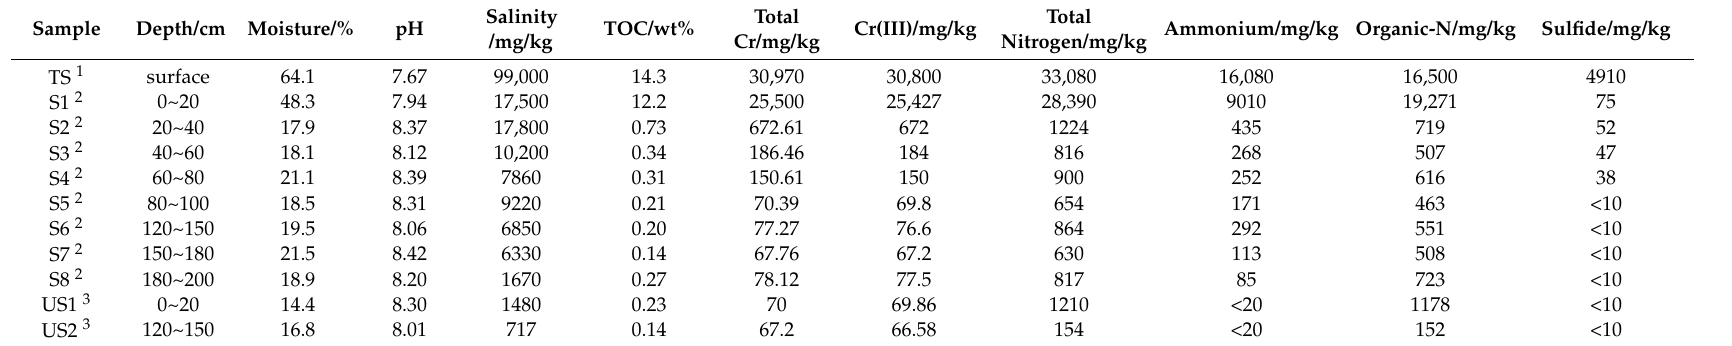
Table 1. Physicochemical characteristics of tannery sludge and soil samples at the different